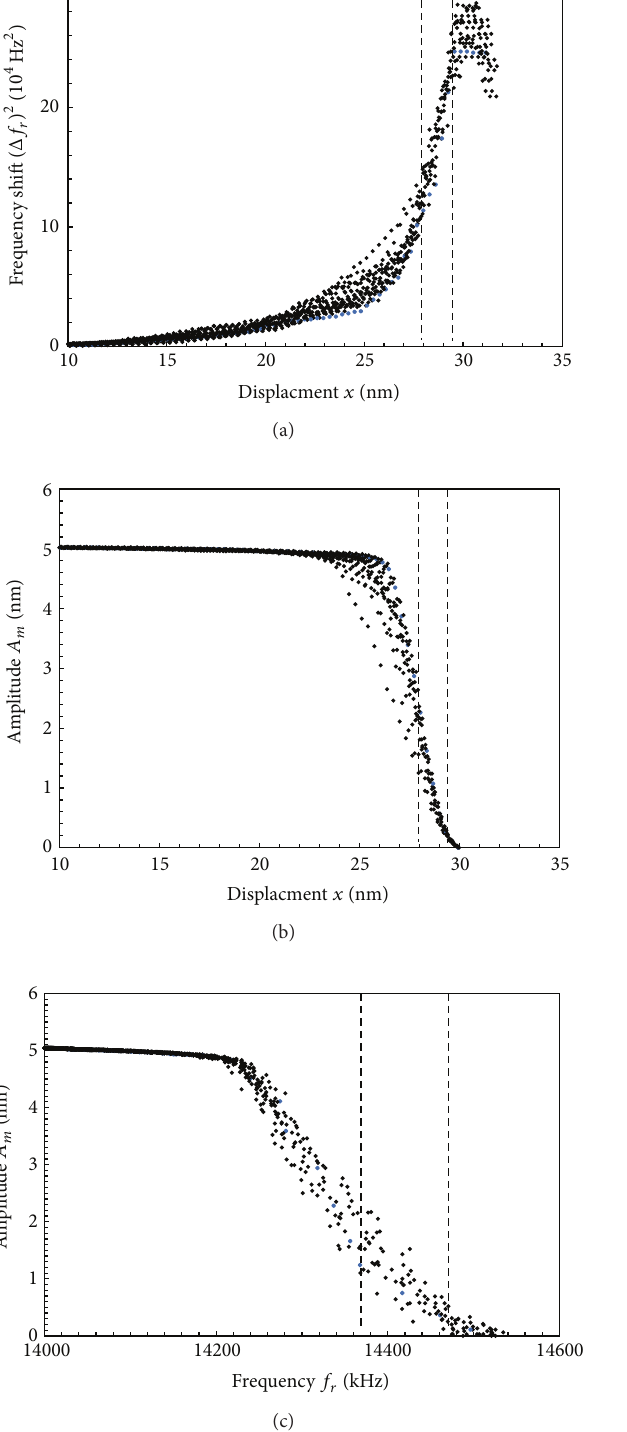
Figure 2: (a) The square of the resonant frequency shift ( Δ𝑓 𝑟 ) 2